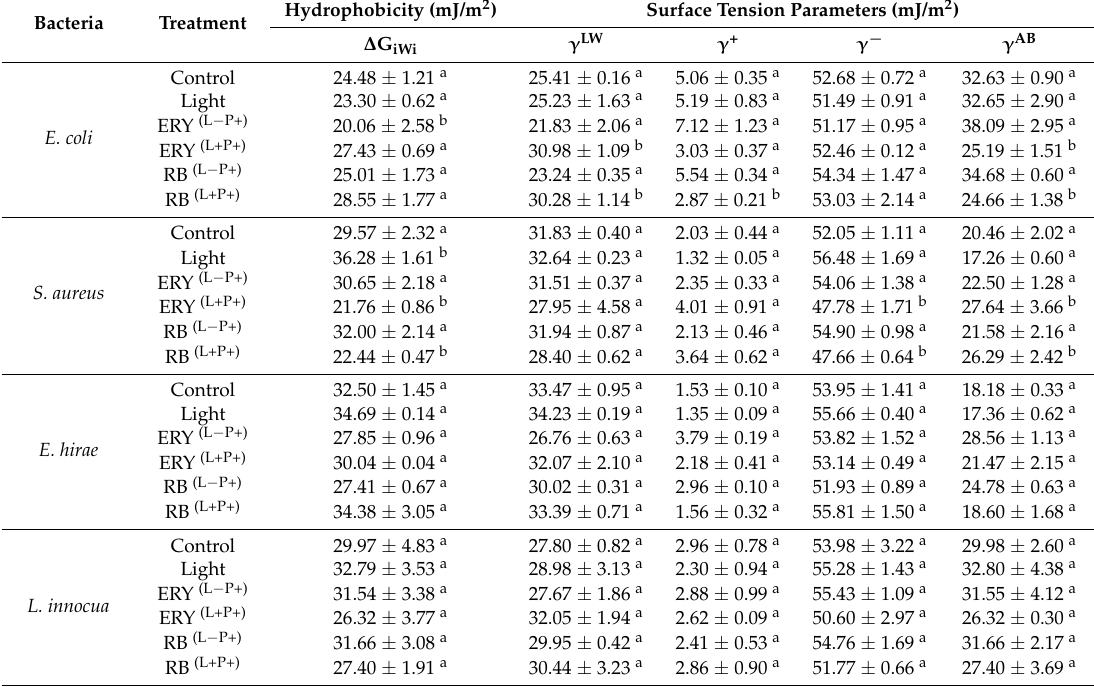
Table 2. Hydrophobicity ( ∆ G iWi ), apolar ( γ LW ) and polar ( γ AB ) components of the surface tension of untreated and aPDI planktonic bacteria.